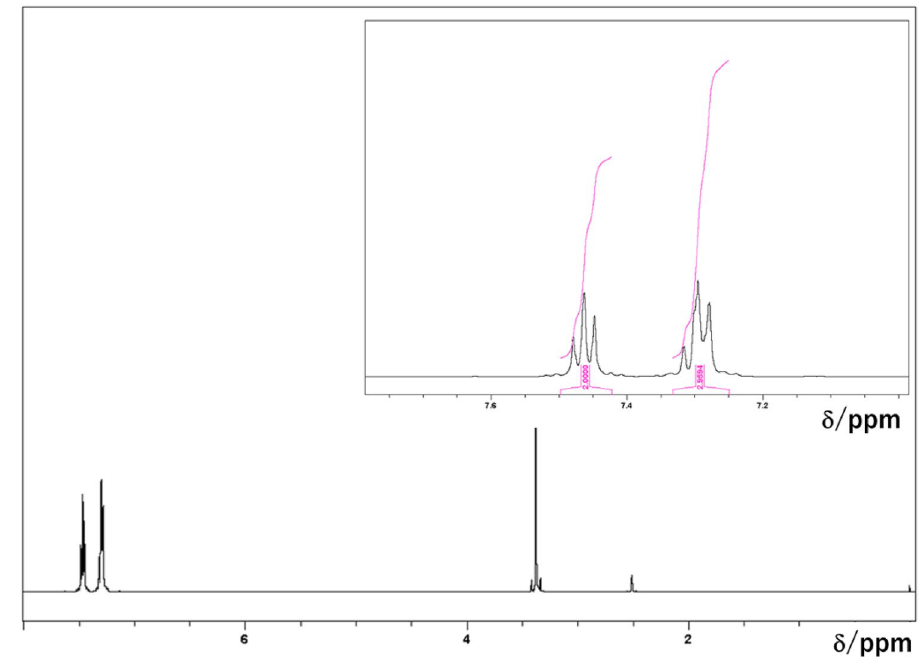
Figure 2. 1 H NMR spectrum of the white